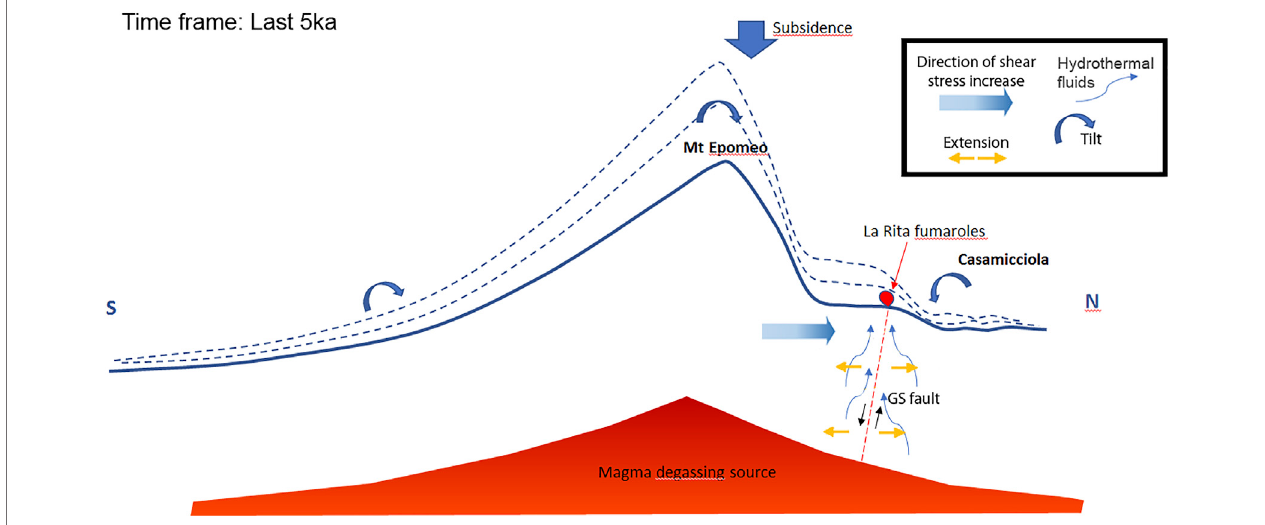
FIGURE 6 | Qualitative sketch of the geological processes favoring the activation of the Grande Sentinella (GS) fault (N-S pro fi le, NOT TO SCALE). Round thick arrows (in blue)indicate the slight tilting ofthe block inferred from horizontal component ofthe GPS stations. Dottedlines (in blue)indicate the former pro fi le position (see text for